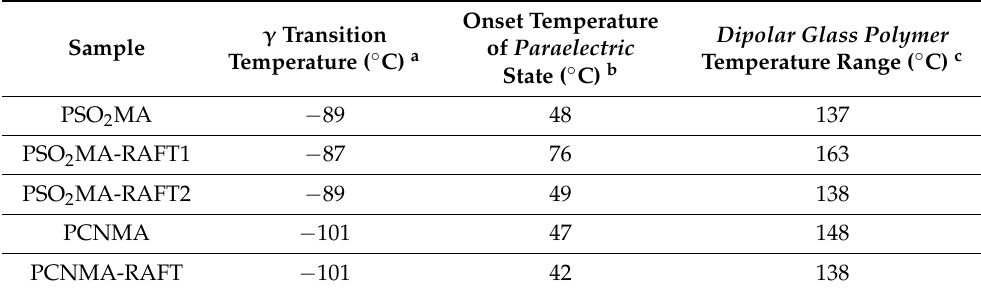
Table 5. Dipolar glass polymer temperature range determined for polymethacrylates obtained conventionally and by